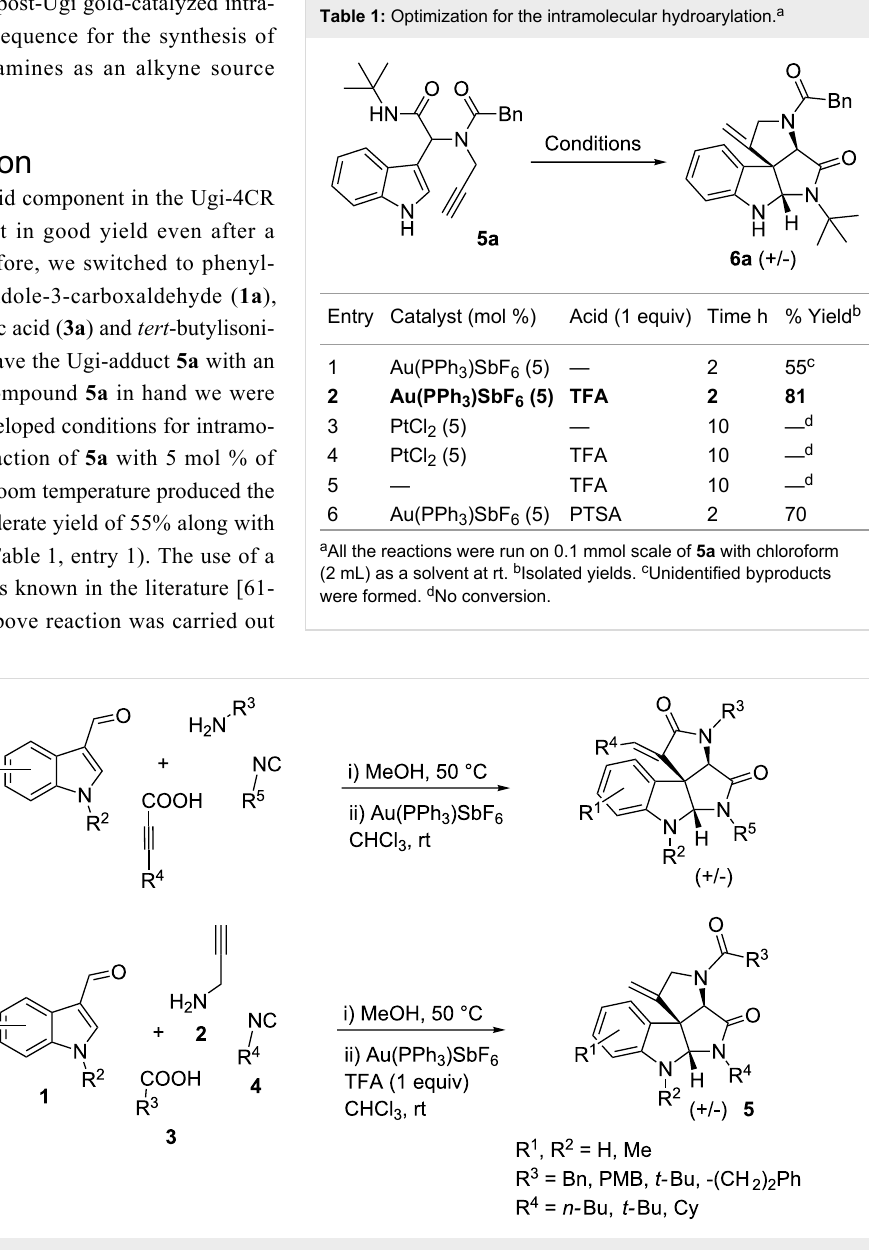
Scheme 1: Gold-catalyzed approaches towards spiroindolines.